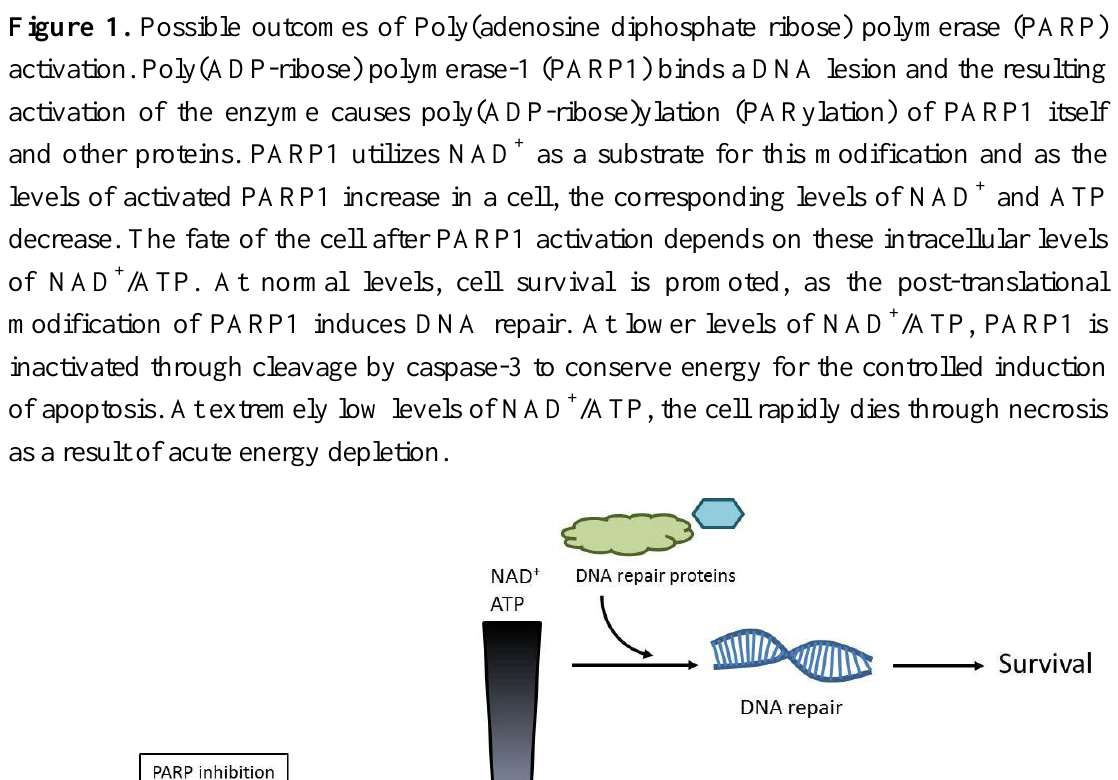
Figure 1. Possible outcomes of Poly(adenosine diphosphate ribose) polymerase (PARP) activation. Poly(ADP-ribose) polymerase-1 (PARP1) binds a DNA lesion and the